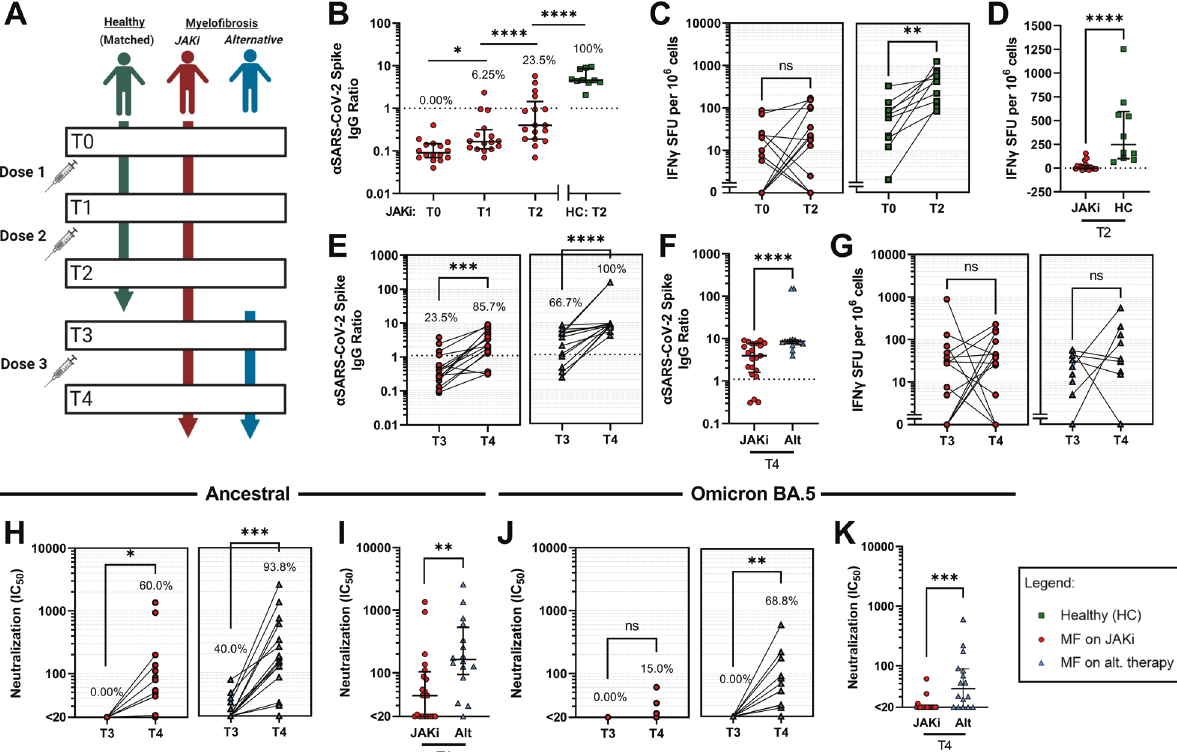
Fig. 1 JAK inhibitor use impairs humoral and cellular immunity to COVID-19 vaccination and limits third-dose protective immunity against Ancestral and Omicron BA.5 variants in myelo fi brosis. A Study design. Immunogenicity of the standard two-dose vaccine schedule was assessed in individuals with myelo fi brosis receiving a JAK inhibitor compared against healthy controls of comparable age, sex distribution and vaccine selection. The effect of a third vaccine dose on correlates of protective immunity against Ancestral and Omicron BA.5 variants was assessed for myelo fi brosis patients receiving a JAK inhibitor compared with those receiving alternative (Alt) therapies. B Anti-SARS-CoV-2 Spike IgG titers (EUROIMMUN) in myelo fi brosis patients receiving a JAK inhibitor, assessed at baseline, and pre- (T1) and post- (T2) administration of a second vaccine dose. Titers measured after a second dose (median 15 days; IQR 14 – 20.5) were compared with those of healthy controls (median 21 days; IQR 20 – 21.5). P values from paired comparisons, from left to right, were 0.017 (Wilcoxon test), <0.0001 (Wilcoxon test) and <0.0001 (Mann – Whitney U test). C Assessment of functional SARS-CoV-2 Spike-reactive T cells by IFN γ ELISpot. Peripheral blood mononuclear cells collected from MF patients on JAK inhibitors and healthy controls at baseline and after 2 vaccine doses were stimulated for 18 h with overlapping peptides spanning the full length of the SARS-CoV-2 Spike protein, and cellular immunity assessed as IFN γ spot-forming units by ELISpot. D Cellular immune response to a two-dose vaccination schedule in myelo fi brosis patients receiving a JAKi and healthy individuals. Change in spot counts from baseline to T2 were calculated in order to account for pre-existing immunity measured in some individuals prior to vaccination. E Anti-SARS-CoV-2 Spike IgG titers (EUROIMMUN) in myelo fi brosis patients receiving a JAK inhibitor or alternative therapy pre- and post-administration of a third vaccine dose. F Comparison of anti-SARS-CoV-2 Spike IgG titers (EUROIMMUN) in myelo fi brosis patients receiving a JAK inhibitor or alternative therapy following a third vaccine dose. G Functional SARS-CoV-2 Spike-reactive T cell counts in myelo fi brosis patients receiving a JAK inhibitor or alternative therapy pre- and post-administration of a third vaccine dose. H Serological neutralization of live SARS-CoV-2 virus Ancestral variant. Percentage of individuals achieving effective neutralization (IC50 ≥ 20) is indicated. I Capacity for neutralization of the Ancestral variant following a third vaccine dose in myelo fi brosis patients compared by treatment. J Serological neutralization of live SARS-CoV-2 virus Omicron BA.5 variant. Percentage of individuals achieving effective neutralization (IC50 ≥ 20) is indicated. K Capacity for neutralization of the Omicron BA.5 variant following a third vaccine dose in myelo fi brosis patients compared by treatment. Signi fi cant difference between time points by Wilcoxon signed-rank test or Student ’ s Paired T test, and between groups by Mann – Whitney U test: ns, non-signi fi cant; * p < 0.05; ** p < 0.01; *** p < 0.001; **** p < 0.0001. For values, see Supplementary Table COVID-19 despite reduced levels of virus-neutralizing antibodies patients on alternative therapies rose from 6/15 (40%) to 15/16 [15]. T cell responses did not improve signi fi cantly after a third (94%; p = 0.0021) (Fig. 1H). Consistent with antibody escape by the vaccination in MF patients. ELISpot counts correlated with anti-S Omicron BA.5 variant, neutralization of BA.5 was reduced for all IgG titer ( r = 0.37, p = 0.047) and with neutralization of A.2.2 groups relative to A.2.2 (Fig. 1H – K; Supplementary Fig. 2). Prior to a ( r = 0.41, p = 0.029), suggesting that patients with a more robust third dose, no MF patients on either treatment demonstrated serological response may have a less impaired T cell response. In a effective neutralization of BA.5 (Fig. 1J). Following a third dose, 69% multivariate linear regression model, only JAKi therapy of patients on alternative therapies demonstrated effective neu- ( β = − 2.735, 95% CI − 4.233 to − 1.237; p = 0.0013) and total tralization, compared with 15% on JAKi. Patients who received at lymphocyte count ( β = 0.9709, 95% CI 0.1609 – 1.781; p = 0.022) least one vaccine dose prior to commencing JAKi therapy tended to were found to predict T3 serologic response. Only male sex was have improved serologic responses (Supplementary Fig. 3). predictive of poorer serological response at T4. JAKi treatment The emergence of SARS-CoV-2 variants that escape vaccine- predicted poorer neutralization against A.2.2 at T3 and Omicron induced humoral immunity has highlighted the importance of BA.5 strain at T4 (Supplementary Tables 4 – 10). By logistic T cells [11 – 14]. In patients with haematological malignancies, high regression and bivariate analysis, only JAKi was associated with CD8 + T cell counts are associated with improved outcomes of